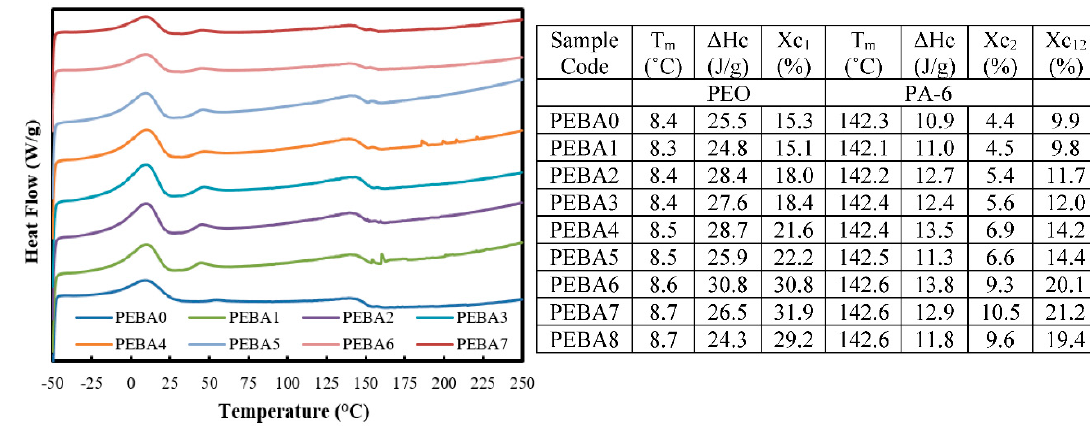
Figure 7. Typical DSC curves and calorimetric data of the synthesized membranes.